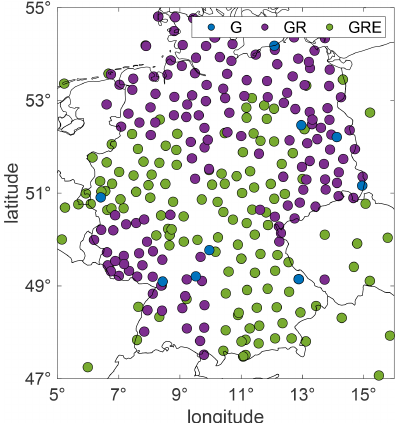
Figure 2. Map of the stations used for Germany. The colors indicate the capability to receive signals from the particular GNSS. Table 3. Statistics between the particular GNSS ZTD solutions av- eraged from all stations for the entire year of 2020. Whole world Germany only (376 stations) (152 stations)